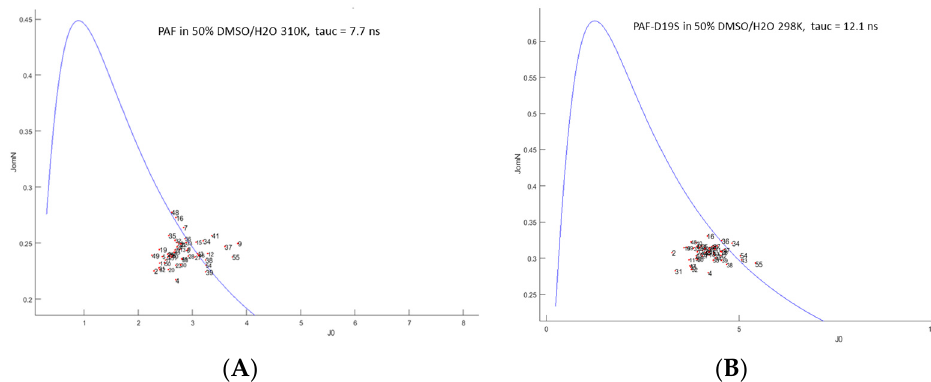
Figure 4. Reduced spectral density mapping as obtained in 50 v / v % DMSO from 15 N relaxation data for PAF (( A ), 310 K) and PAF D19S , (( B ), 298 K). The same input experimental data were used as for Figure 3 (see also Supplementary Table S1). The continuous curve represents the absence of internal motion. Spectral densities (i.e., the strength of radiofrequency (RF) fields from molecular motions) at the 15 N frequency JomN are shown as a function of RF fields close to zero frequency J0 (slow-motion regime). The units of both axes are 10 − 9 (s rad − 1 ).